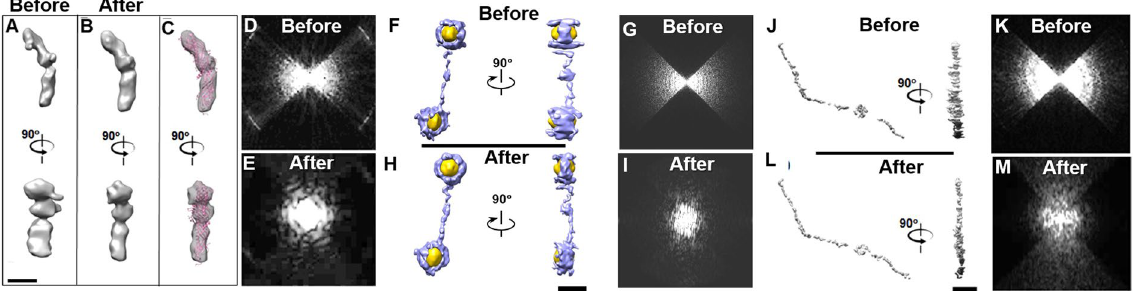
Figure 5. Missing-wedge correction of the NS single-molecule 3D reconstructions. ( A ) Two perpendicular views of a single-molecule 3D density map (low-pass filtered at 8 Å) of an individual CETP particle reconstructed by IPET on the NS tilt series (a portion of tilt series from − 45° to + 45° in steps of 1.5° was used for 3D reconstruction) after CTF correction and contrast enhancement 25 . ( B ) The corresponding views of the 3D map after the 1,000 iterations of missing-wedge correction. ( C ) The corrected 3D density map rigid- body-docked with the crystal structure of CETP. ( D , E ) Fourier transforms of X-Z projections of the initial and final 3D maps. ( F – I ) The missing-wedge correction on a 3D map of an individual complex of DNA-nanogold conjugate imaged by NS ET and reconstructed by IPET from a portion of the tilt series (from − 45° to + 45°